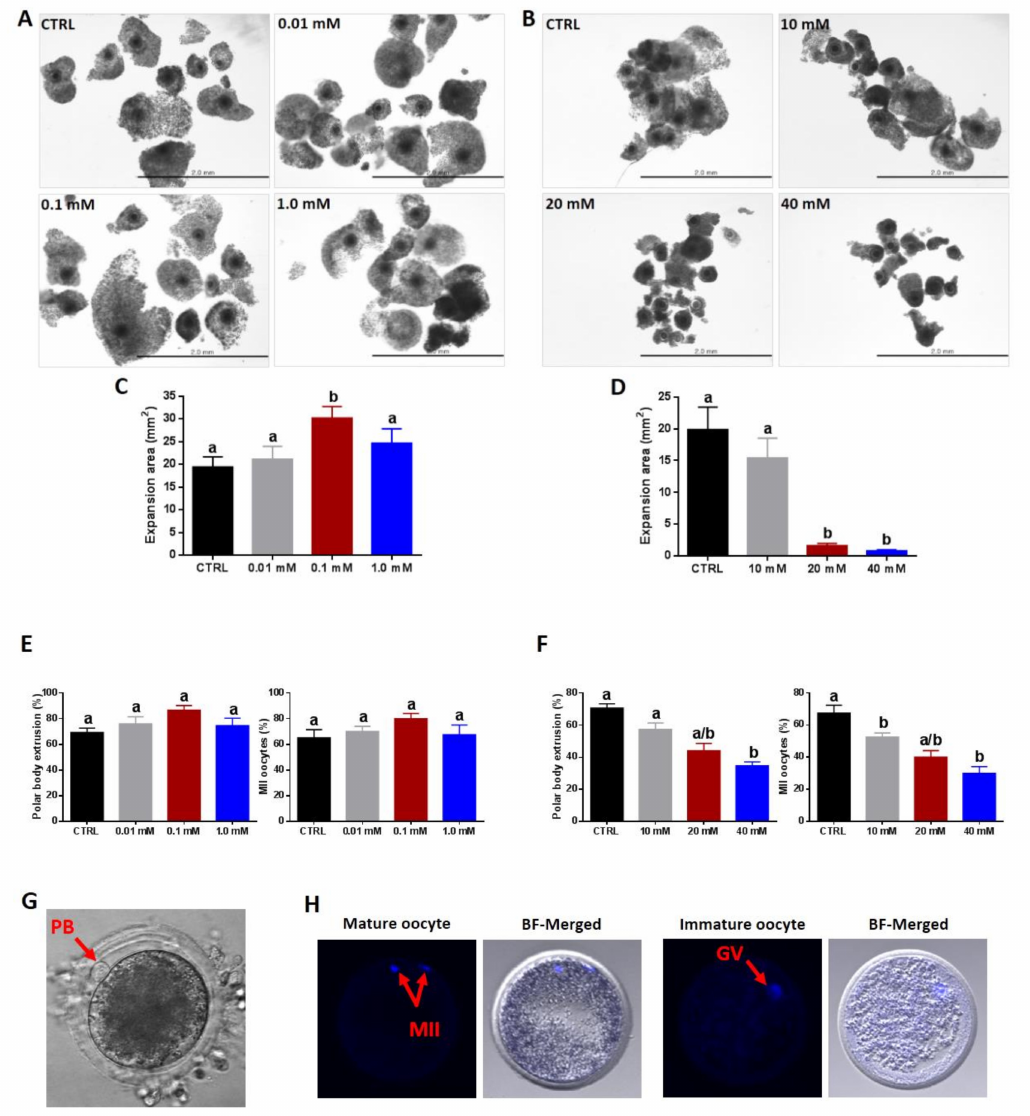
Figure 1. The effect of nicotinamide (NAM) on cumulus expansion and oocyte maturation. Light microscopy for cumulus–oocyte complexes (COCs) post-maturation in the presence of low ( A ) and high ( B ) NAM concentrations. The increase in the expansion area of COCs matured under low ( C ) and high ( D ) NAM concentrations. ( E , F ) Percentages of in vitro matured oocytes following NAM treatment. Representative images for polar body ( G ) and 4 (cid:48) ,6-diamidino-2-phenylindole (DAPI) staining ( H ) of mature and immature oocytes. Scale bar = 2.0 mm. PB: Polar body; MII: metaphase II; GV: germinal vesicle. Superscripts with different letters indicate statistical